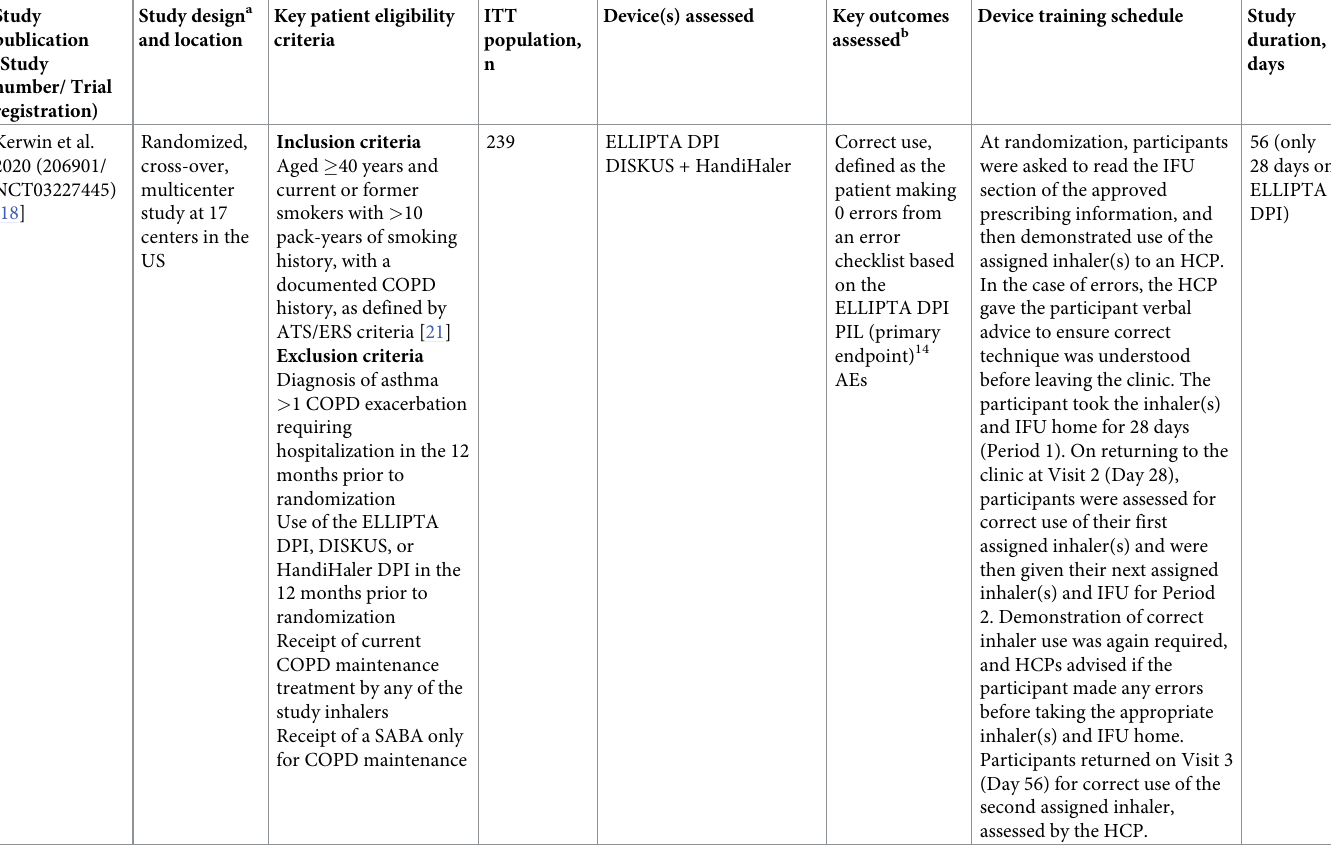
Table 2. Patients’ mean age was 66.2 years and 31% had a COPD history of � 10